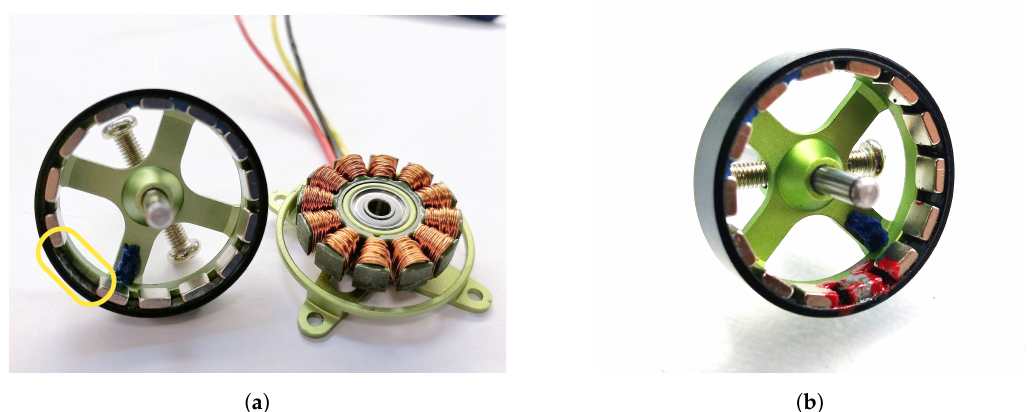
Figure 10. Demagnetisation process: rotor with a missing magnet ( a ), highlighted by the yellow circle, and rotor with the replacement piece of inert material ( b ), easily recognisable for the red glue.